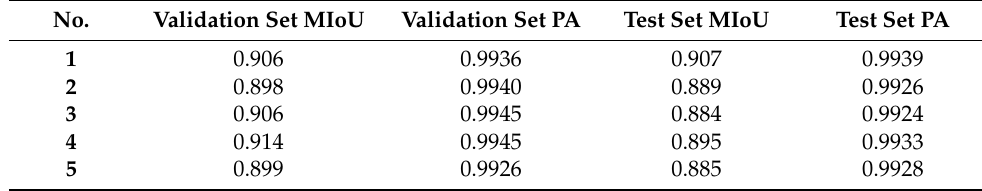
Table 8. Monte Carlo